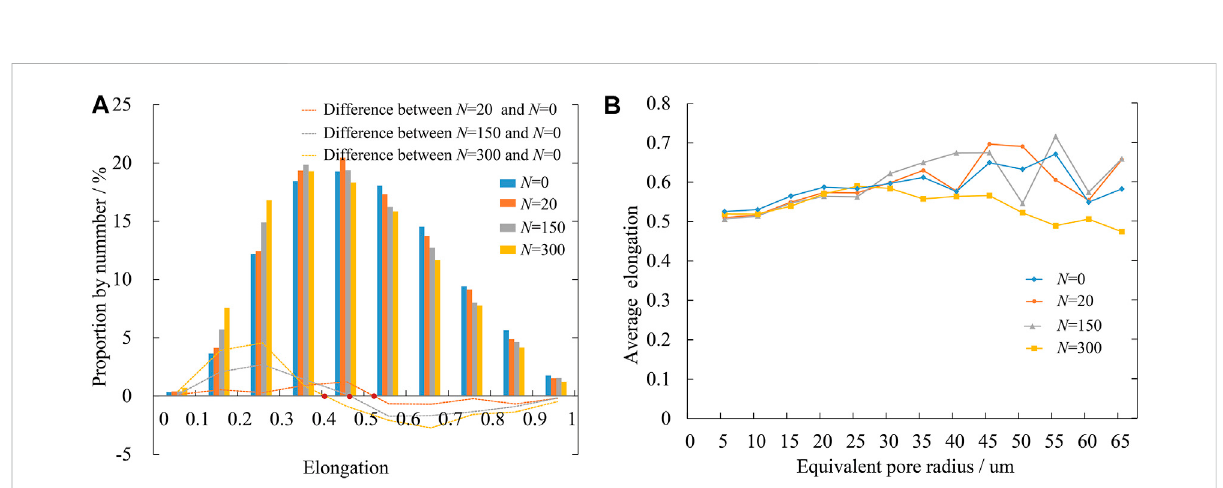
Pore elongation